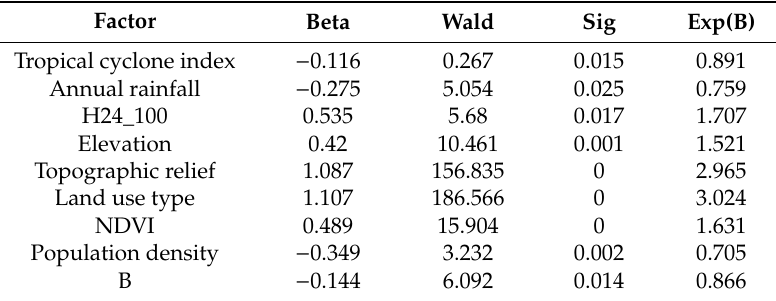
Table 5. The results of the logistic regression analysis.